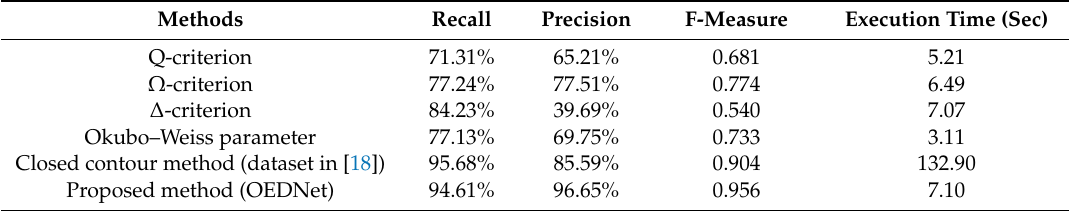
Table 1. Comparison of content related to eddy detection via multiple methods.